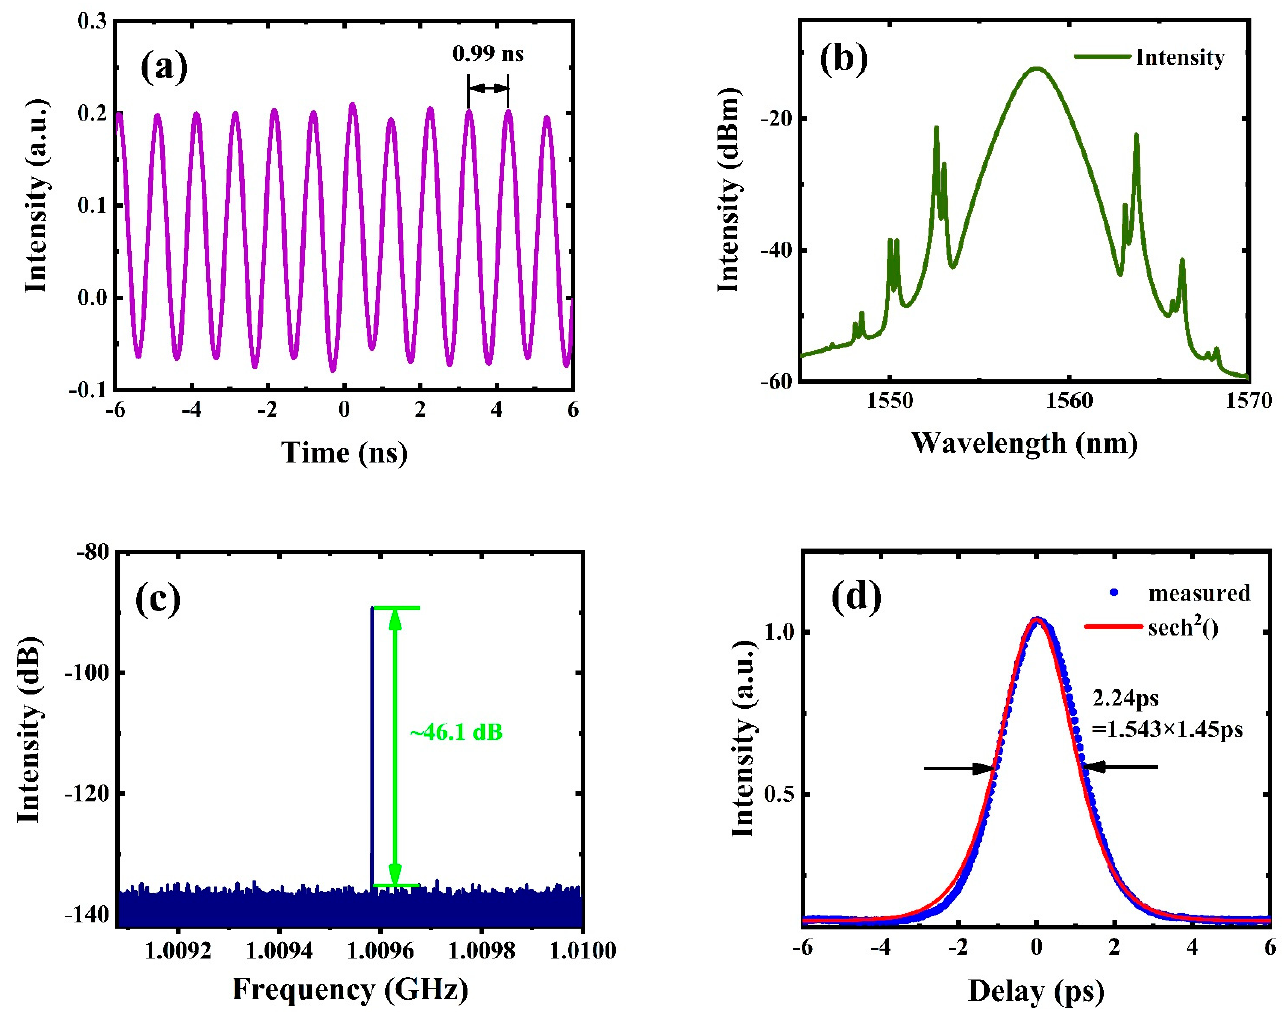
Figure 6. Characteristic diagrams of output pulses at 580 mW. ( a ) Pulse trains. ( b ) Spectrum. ( c ) RF spectrum. ( d ) Autocorrelation curve.